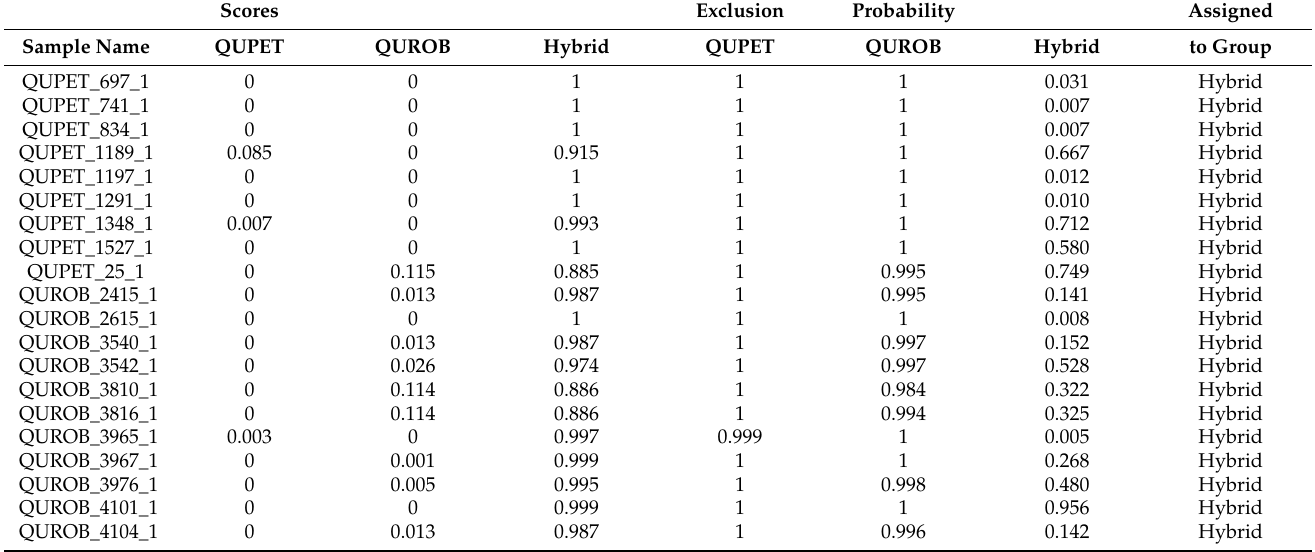
Q. robur. All 20 potential hybridized specimens were assigned to the hybrid group (Table 5). Table 5. Result of a self-assignment test with the 20 hybrids also used as reference